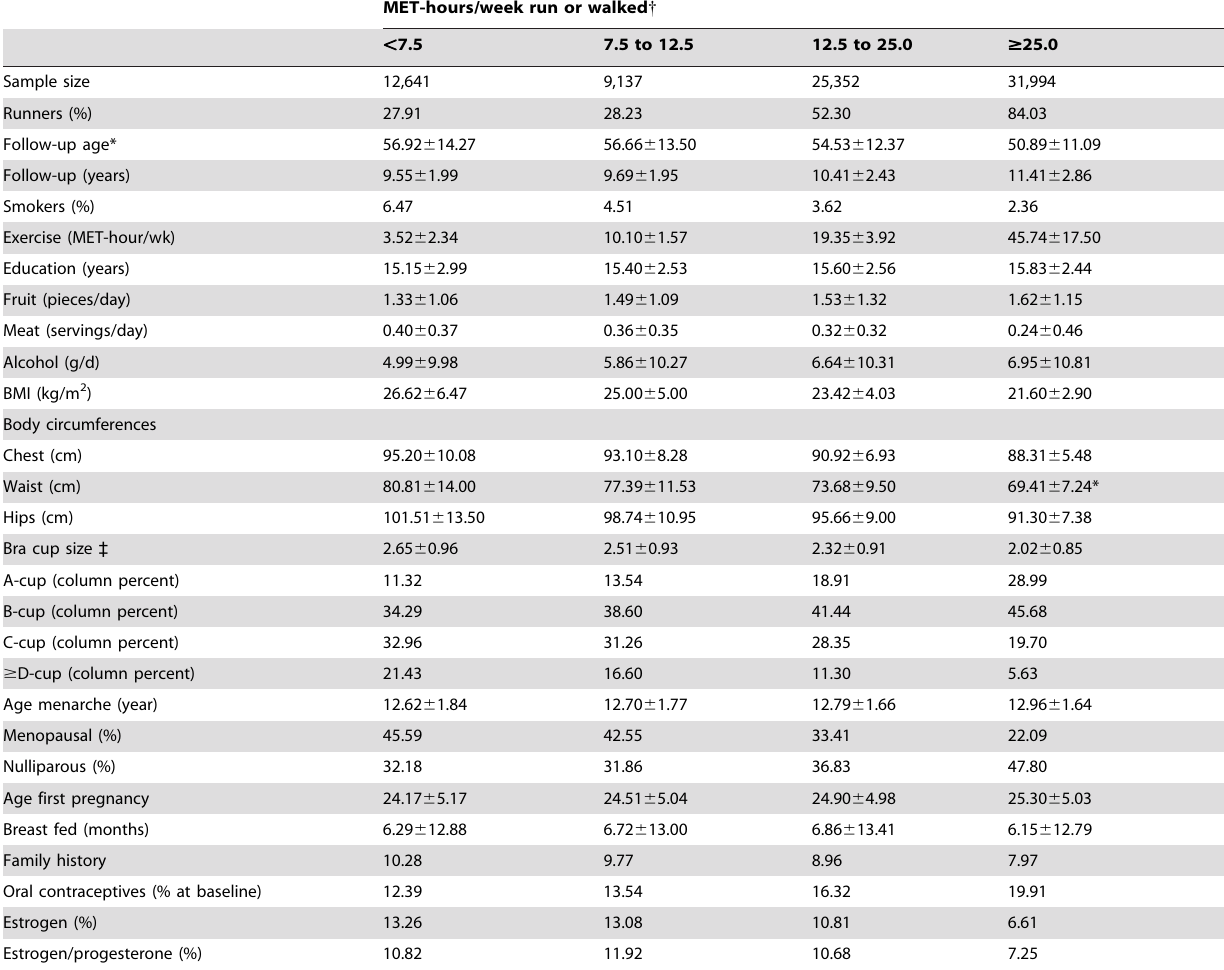
Table 1. Sample characteristics by MET-hours/week/d